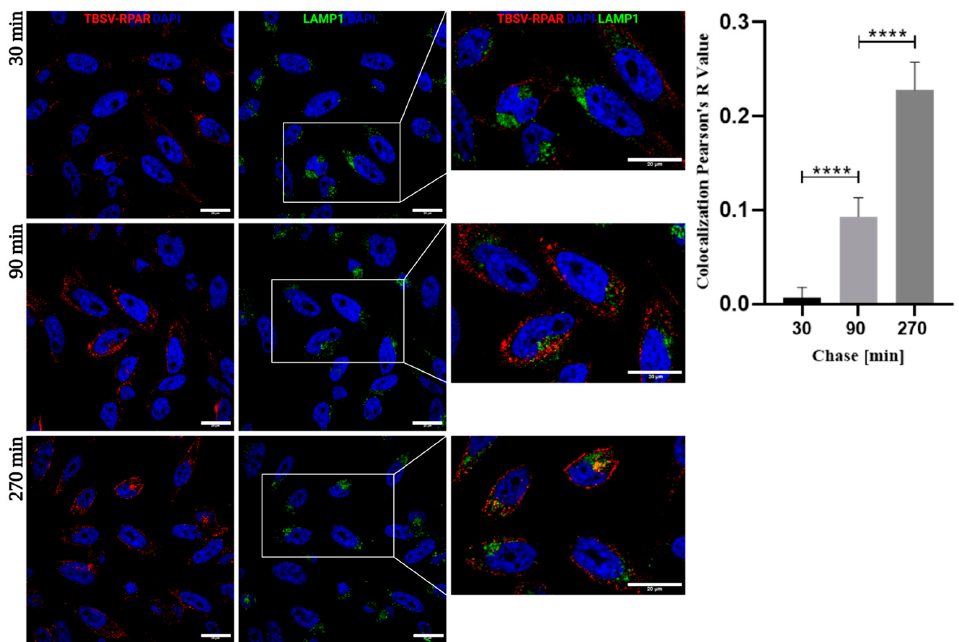
Figure 5. Internalized TBSV-RPAR NPs are routed to the LAMP-1-positive lysosomal compartment. PPC-1 cells were incubated with TBSV-RPAR for 30 min, washed to remove unbound NPs, and imaged at 30, 90, and 270 min time points. The cells were stained with lysosomal marker LAMP-1 (green) and anti-TBSV antibody (red). Blue: DAPI (nuclei). Scale bars = 20 µm. The relative co-localization was quantified using ImageJ software with the Pearson’s R value shown in the bar chart. **** p < 0.0001 (Student’s t -test).